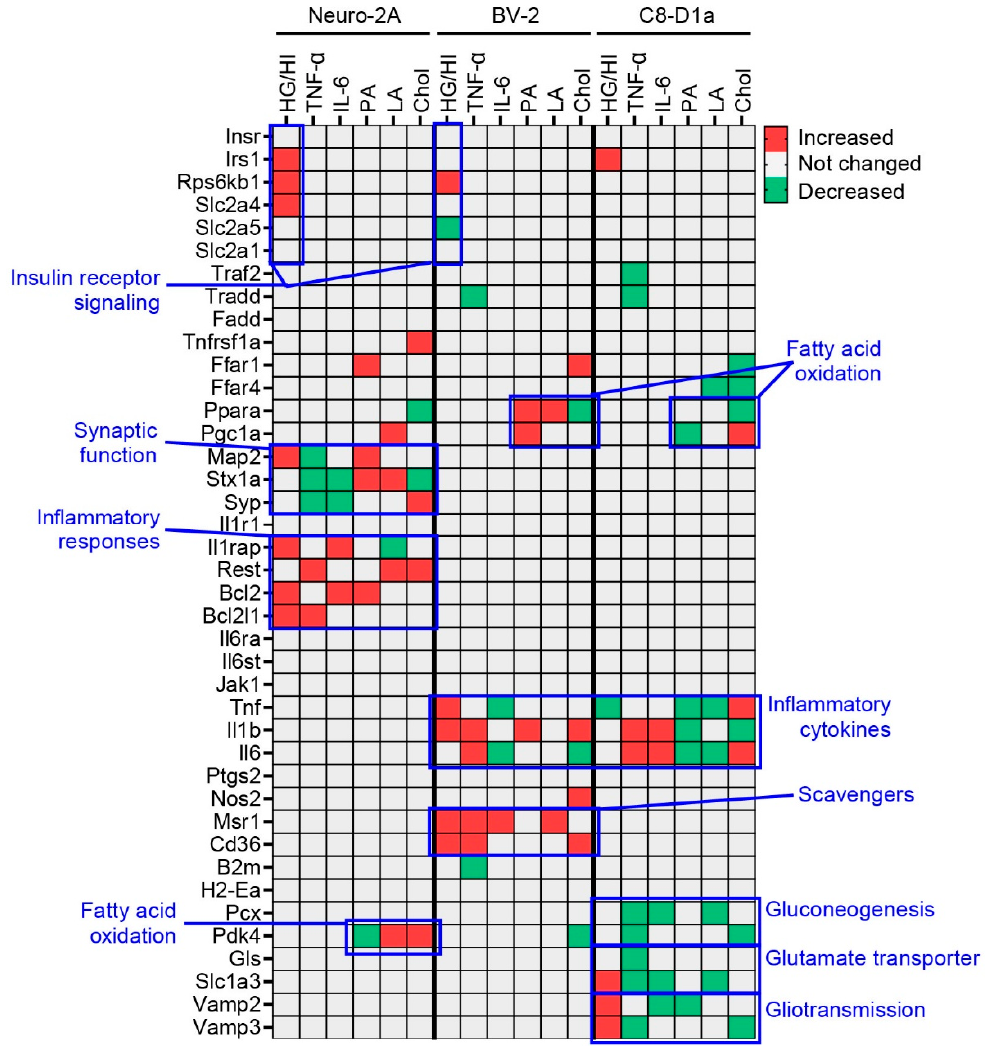
Figure 3. The heatmap displays upregulated and downregulated genes associated with functions by cell type and obesity-related serum factor in three mouse-brain cell lines under obesity-like conditions compared to normal controls. The blue letters and boxes represent clusters of genes that function similarly. The data are expressed as “increased” when the gene expression was significantly increased in cells under obesity-like conditions compared to controls (Red). “Not changed” indicates no significant changes in gene expression in cells under obesity-like conditions compared to normal controls (Silver). “Decreased” indicates the gene expression was significantly decreased in cells under obesity-like conditions compared to normal controls (Green). The data values used in the heatmap are expressed as a histogram in Supplementary Figure S11A–F. HG/HI: high glucose and insulin concentration, TNF- α : tumor-necrosis factor-alpha, IL-6: interleukin-6, PA: BSA-conjugated palmitic acid, LA: BSA-conjugated linoleic acid, Chol: cholesterol, Neuro-2A: mouse neuroblastoma cells, BV-2: mouse microglial cells, C8-D1a: mouse astrocytes.